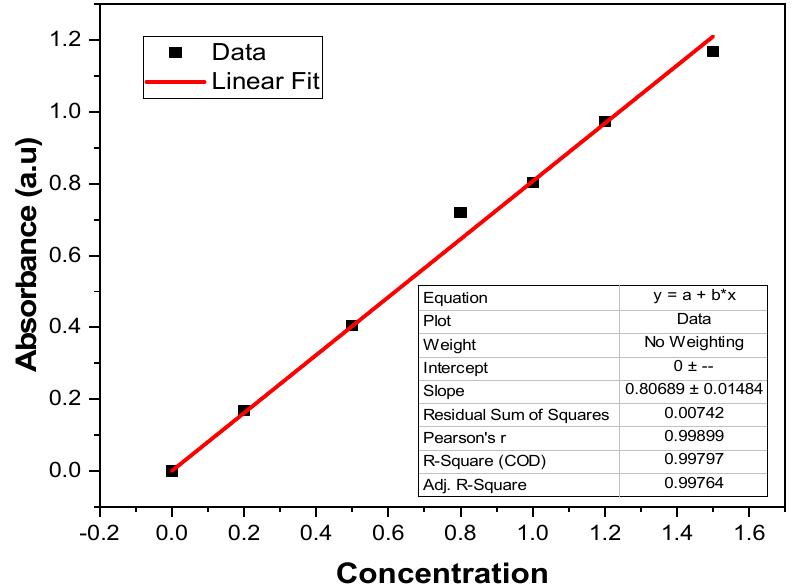
Figure 8. Linear fit of light absorbance by methylene blue dye solution.